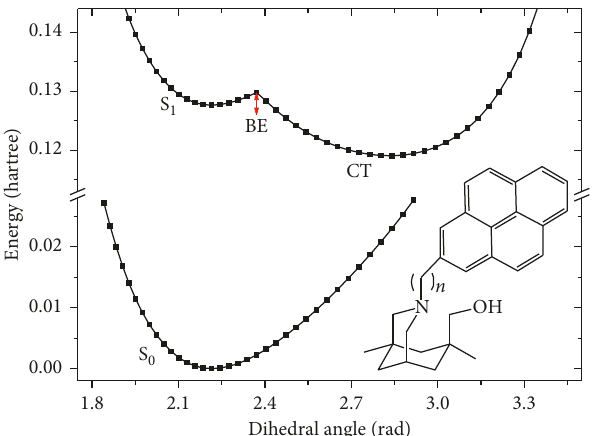
Figure 2: Potential energy curves of the ground (S excited state (S 1 ), and CTstate of the t -amine-pyrene molecule with 4 CH 2 spacers with respect to the dihedral angle of the N atom of the amine at the B3LYP/6-31G(d,p) level of theory. Inset: t -Amine- pyrene molecule, with n numbers of CH 2 spacer units. Table 1: Absorption, emission, and CT transition λ (nm) and f- values of tertiary amine-pyrene molecules at the B3LYP and PBE0/ 6-31G(d,p) levels of theory. Spacer